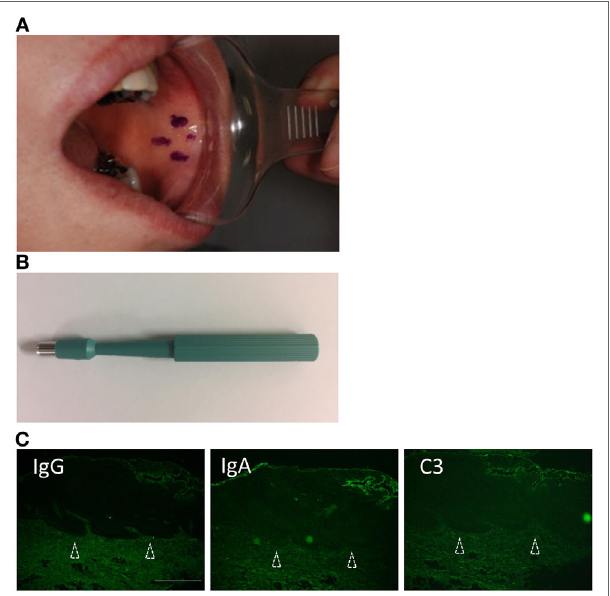
FigUre 1 | Biopsy from non-lesional buccal mucosa. (a) Non-lesional buccal mucosa marked by crystal violet was biopsied under the local anesthesia. (B) The samples were taken using a 4-mm punch biopsy tool. No closing sutures were needed. (c) A healthy individual shows no evidence of IgG, C3, or IgA. Scale bar = 100 µm.